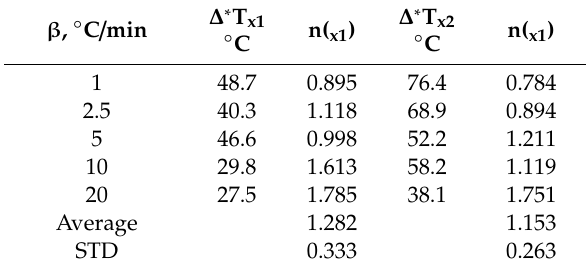
Figure 9. Example of the peak separation and the determined ( ∆ *T) values and the Avrami coe ffi cient (n). Table 2. Determined values of ( ∆ ∗ T x1 ), ( ∆ ∗ T x2 ), and the Avrami coe ffi cient n(x1) and n(x2). β , ◦ C /